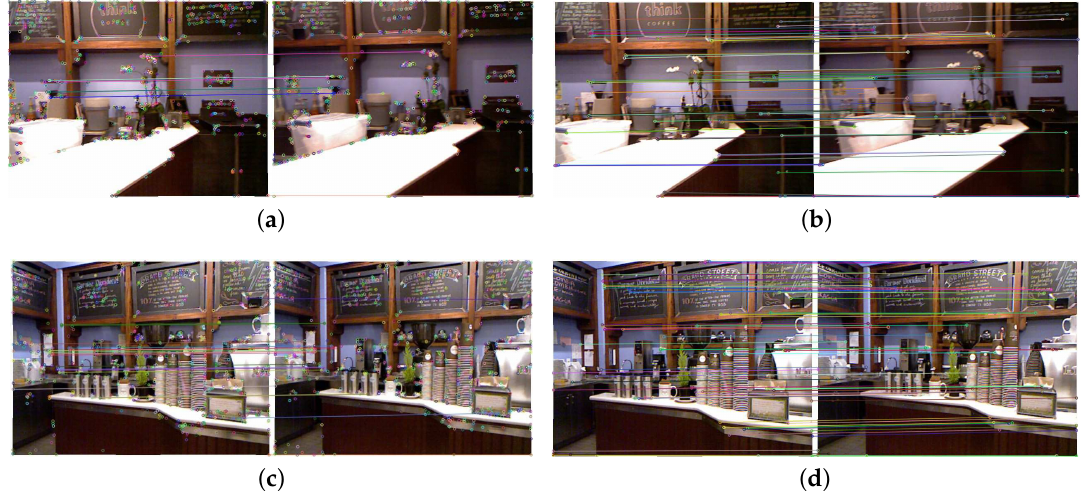
Figure 7. ( a , c ) extract feature points in the whole image, ( b , d ) divide the image equally into 16 cells and extract feature points in every cell. We find that the feature points in ( b , d ) are significantly more than ( a , c ), and the feature points are more evenly distributed. ( a ) Extract feature points in whole image, and good match condition is 5 times the minimum distance. ( b ) Divide image equally into 16 cells and extract feature points. ( c ) Extract feature points in whole image, and good match condition is 5 times the minimum distance. ( d ) Divide image equally into 16 cells and extract feature